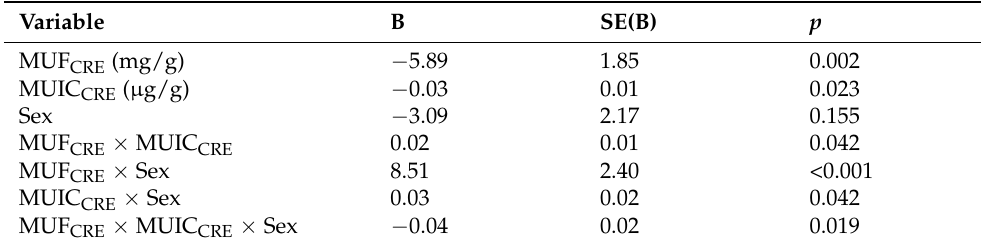
Table 3. Results of the three-way interaction